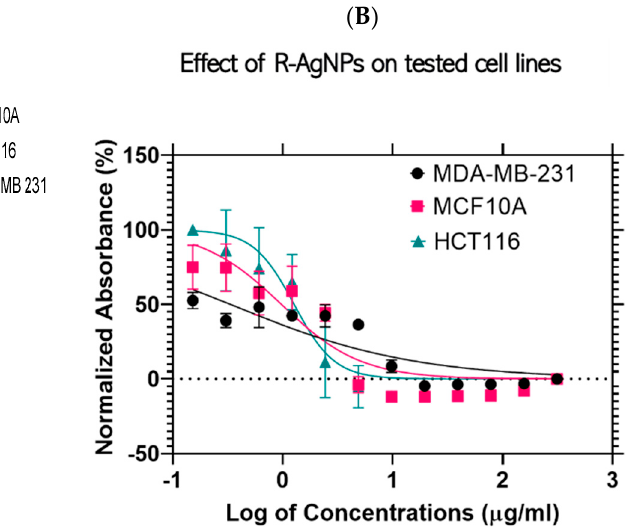
Figure 12. Effect of R- AgNPs on the cell viability of normal and cancer cells. Bar graph showing dose relationship of R- AgNPs on the viability of two human cancer cell lines; HCT116 ( ) and MDA-MB-231 ( ) and a normal cell line; MCF 10A ( ) ( A ). Log dose-response relationship of R-AgNPs on the normalised viability of two human cancer cell lines; HCT116 ( ) and MDA-MB-231 (